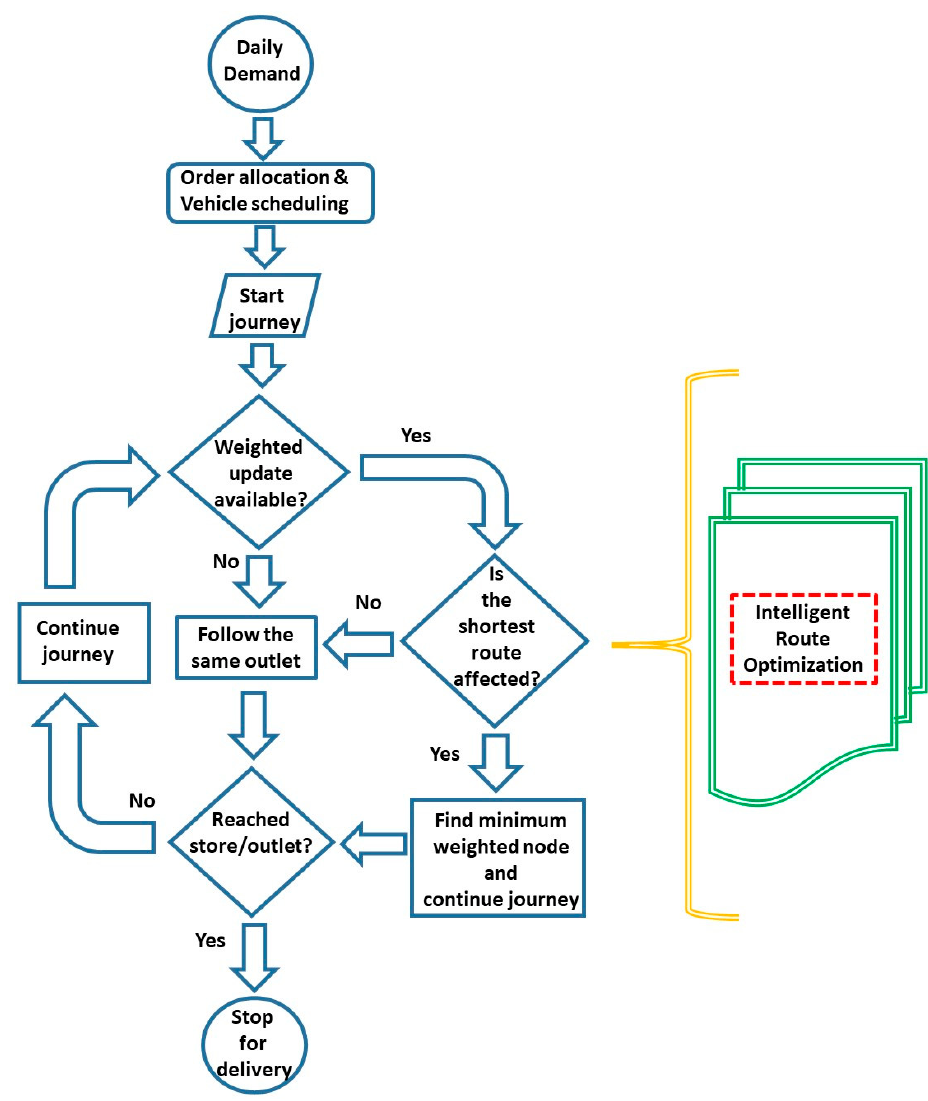
Figure 8. Intelligent vehicle routing optimization process flow.